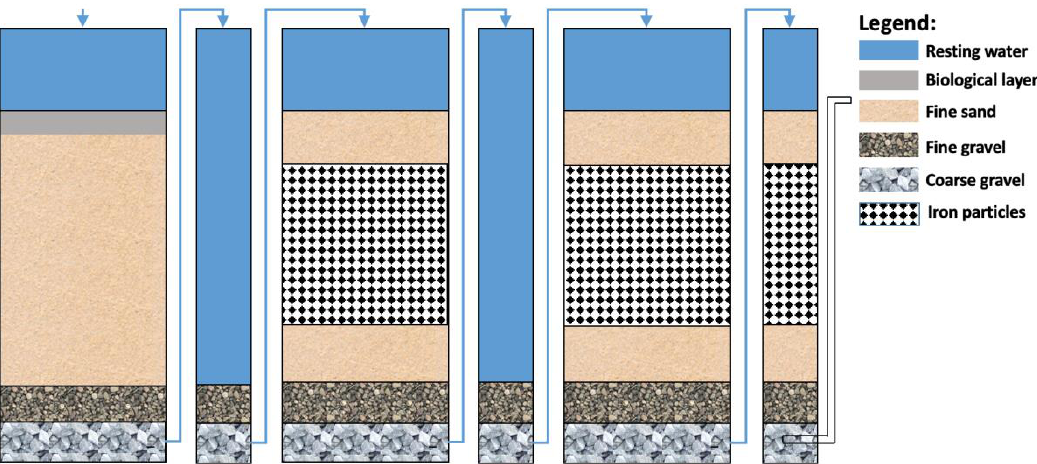
Figure 3. A conceptual depiction of the proposed multi-stage Fe 0 - biological sand filters (BSF) water treatment device. From the left to the right: a biosand filter, a first equalizing filter, a first Fe 0 / sand filter, a second equalizing filter, a second Fe 0 / sand filter, and a filter clock.